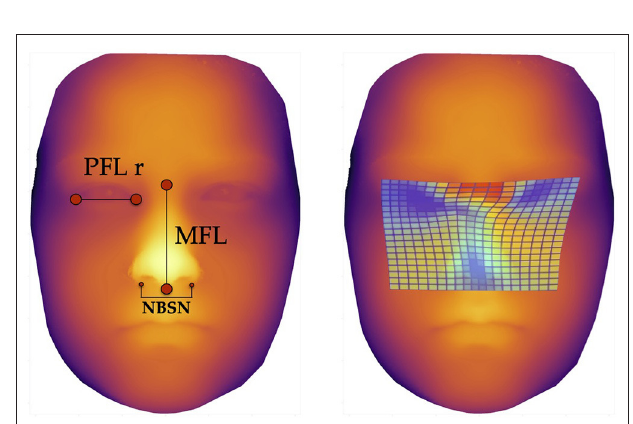
FIGURE 3 | Facial landmarks and thin plate spline visualization. The left image shows the landmarks for measurement of the three predictors for machine learning methods, defined via results of the ANOVA-F analysis (PFL r, MFL, and NBSN); the image on the right side shows thin plate spline. These thin plate splines enable visualization of aberrant facial structures. The blue areas show lower distances for palpebral fissure length, midfacial length and nose breadth at sulcus